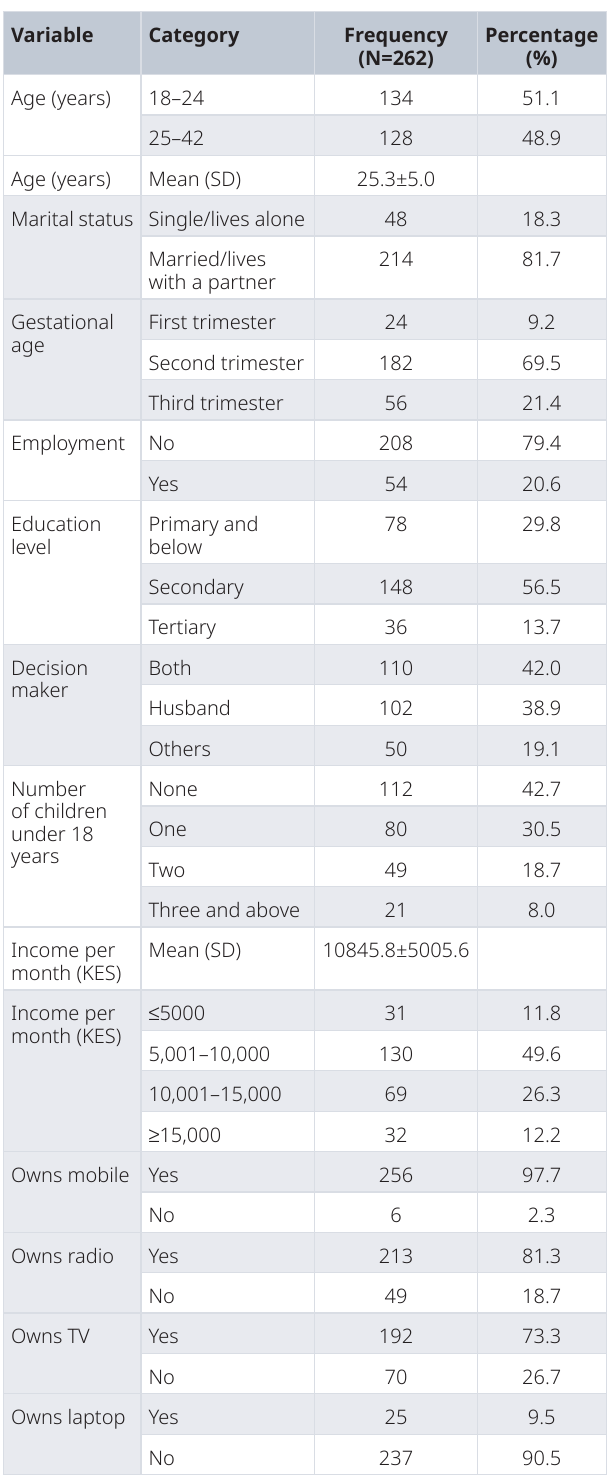
Table 1. Socio-demographics characteristics of pregnant women from urban low-income settlements in Nairobi,